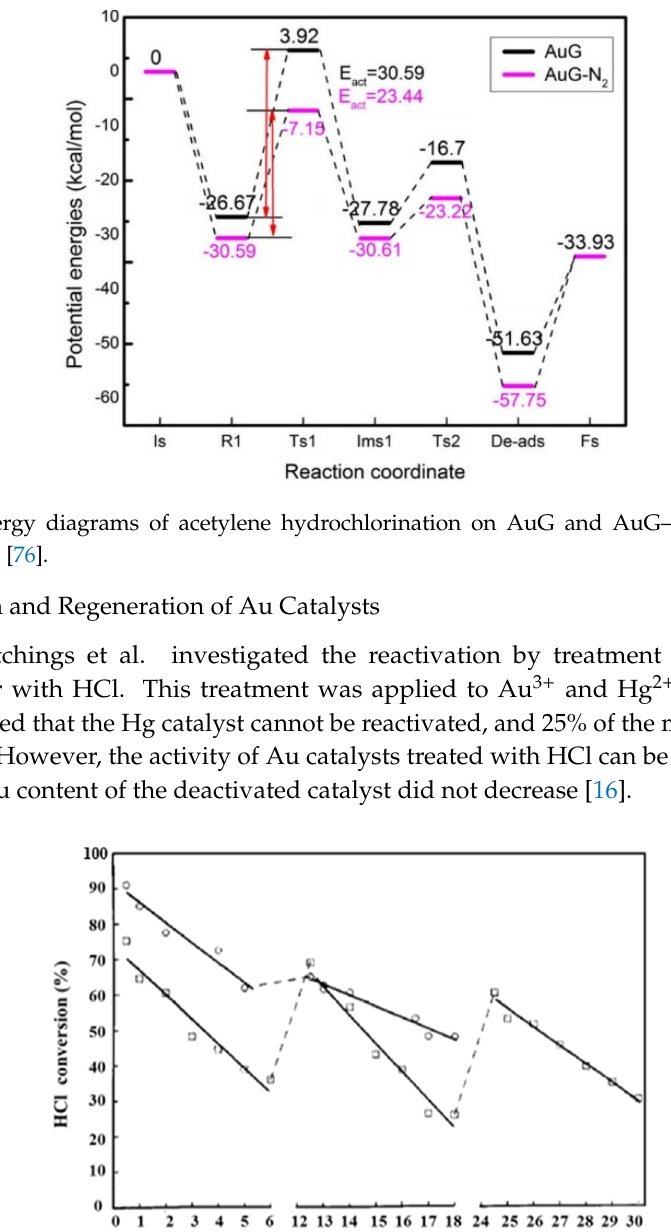
HgCl 2 / C, 9% Hg; (cid:3) HAuCl 4 / C,